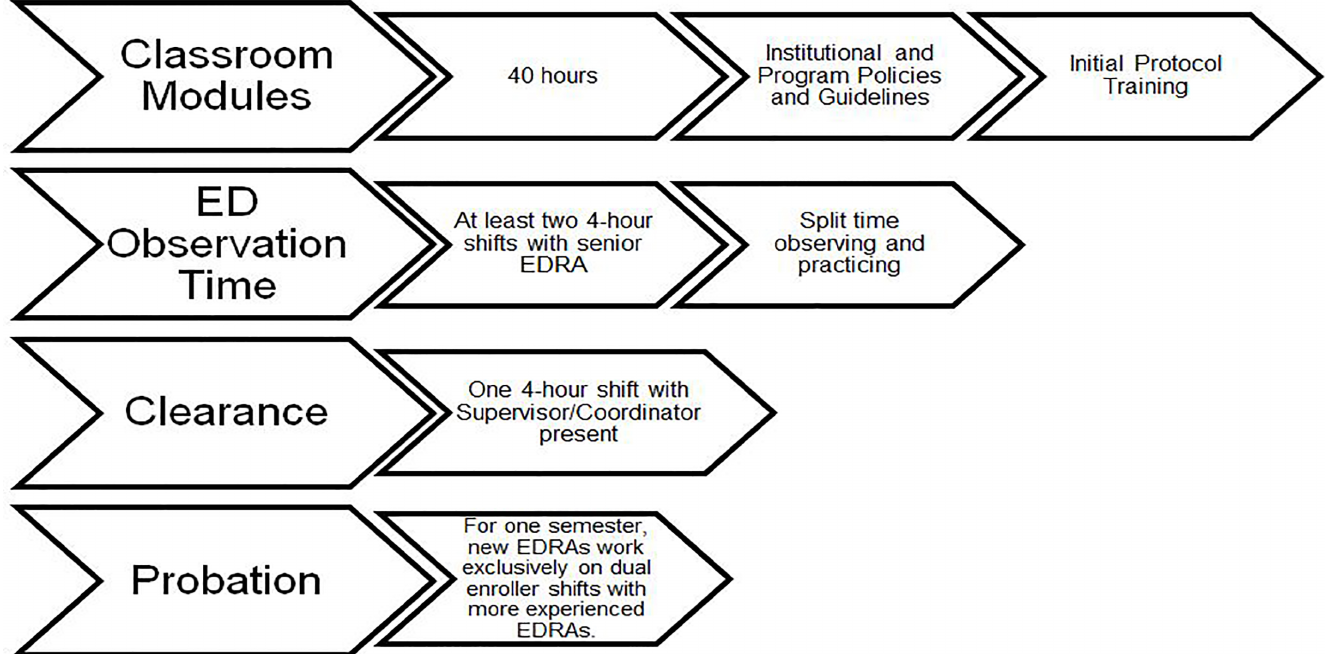
Figure 2. Emergency Department Research Associates (EDRA) initial training